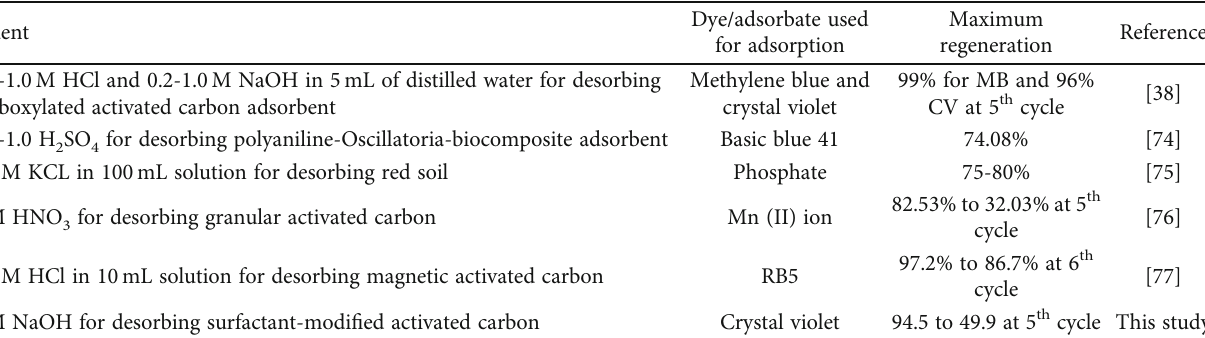
Table 14: Desorption capacity comparison for di ff erent eluents.